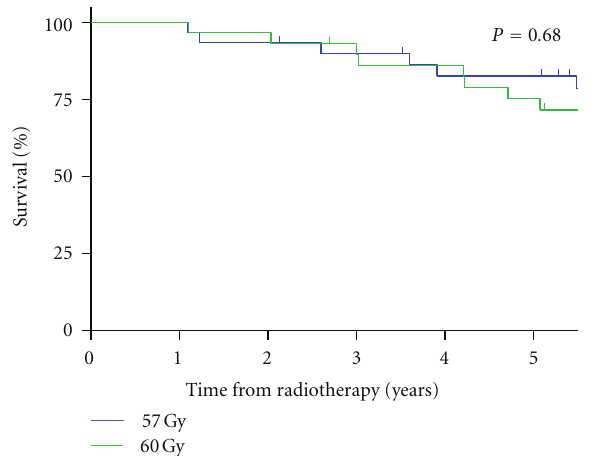
Figure 2: Kaplan-Meier estimates for biochemical progression-free survival for the two fractionation schedules, 57 Gy in 19 fractions and 60 Gy in 20 fractions.